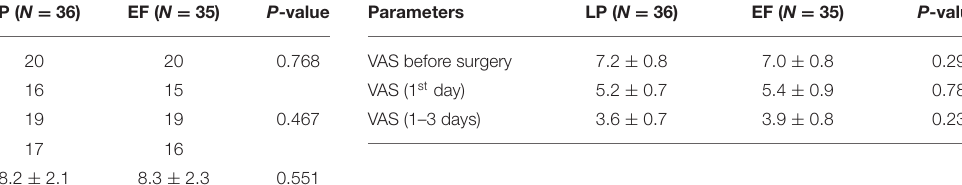
TABLE 4 | Complications after surgery.